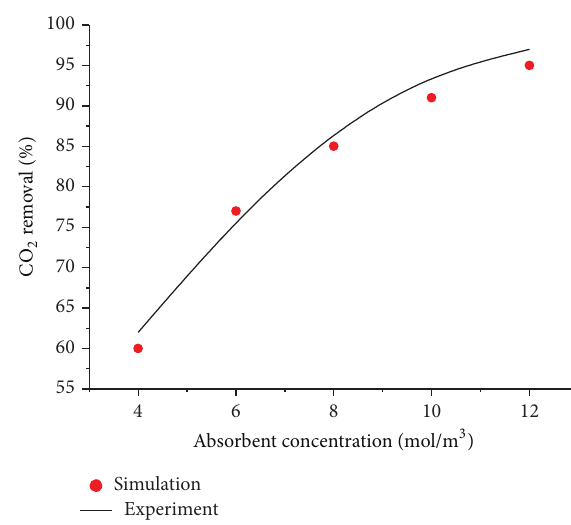
Figure 2: Comparison of simulation values with experiment results. 𝐶